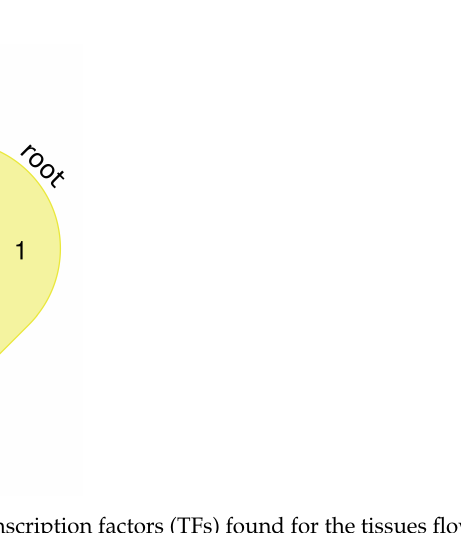
Figure 1. Venn diagram for the enriched transcription factors (TFs) found for the tissues flower, leaf, stem, and root of B. napus (visualized with